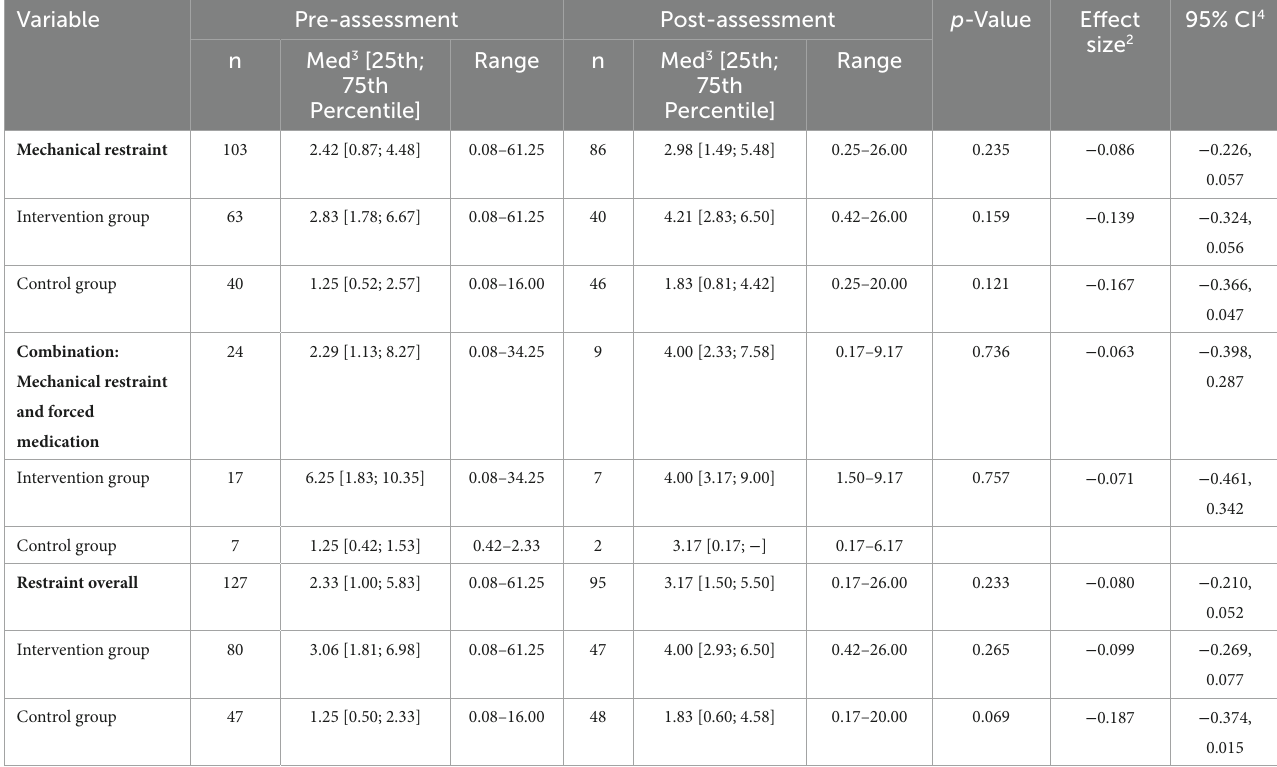
TABLE 4 Duration (in hours) of events of restraint with regard to patients who were exposed to restraint separated by group (IG or CG) before (pre) and after (post) the implementation of peer support ( n = 222) 1 .